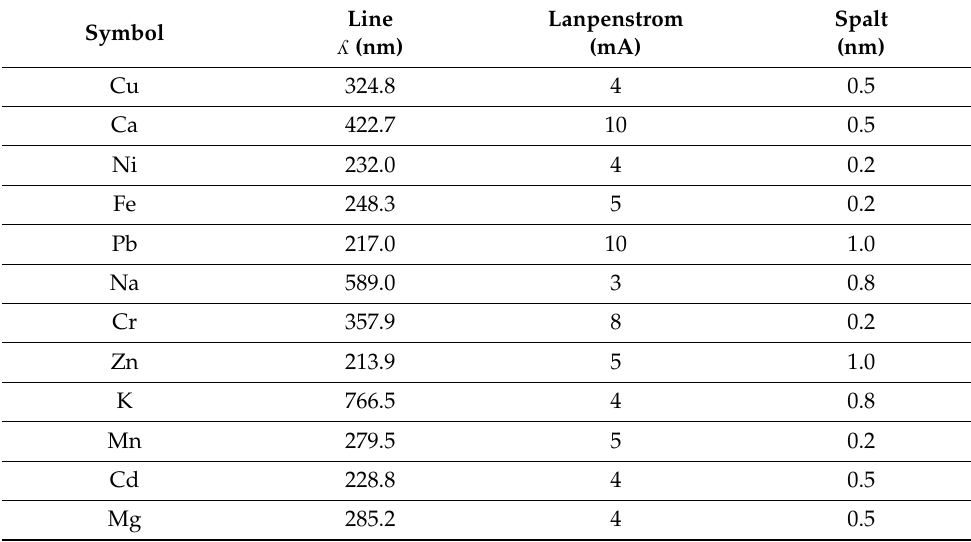
Table 4. The parameters used to read the mineral